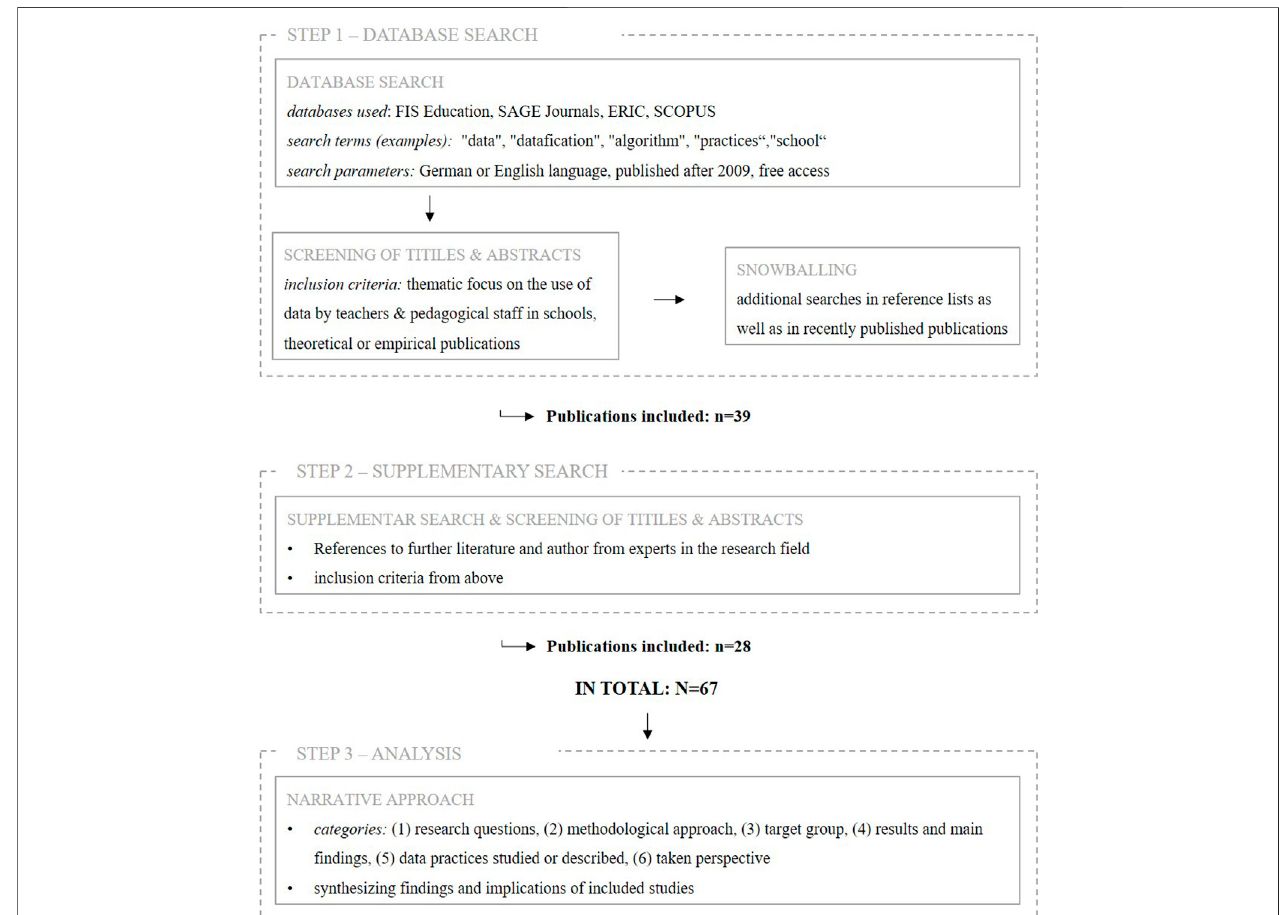
FIGURE 1 | Methodological